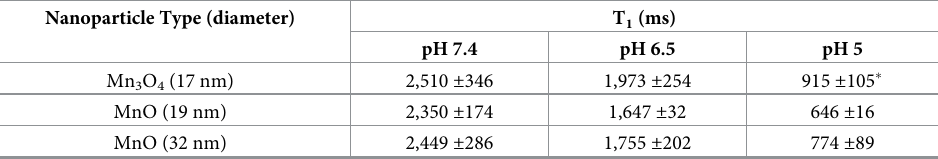
Table 2. MRI T 1 values of supernatants collected between 8 and 24 hours after NP incubation at pH 7.4, 6.5 and 5. Nanoparticle Type